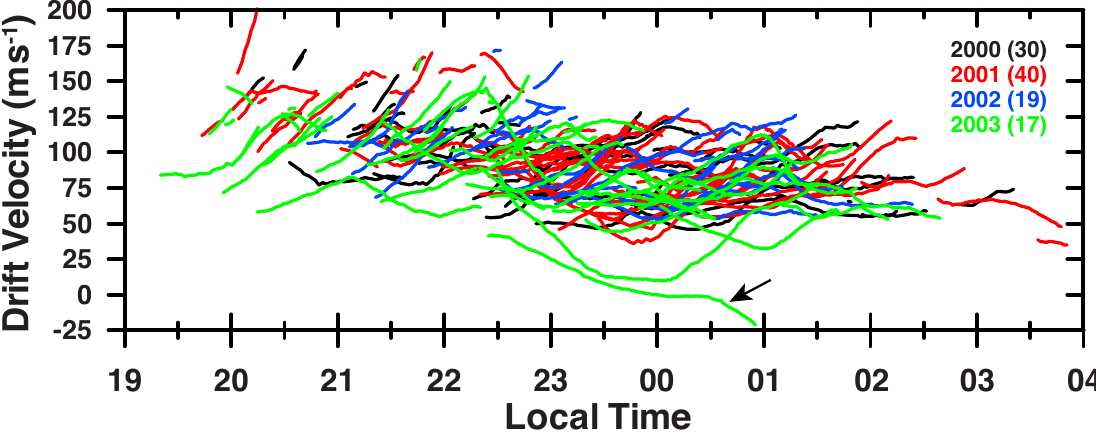
Figure 4. Instant zonal drift velocities for EPBs in Cariri from 2000 to 2003 as a function of local